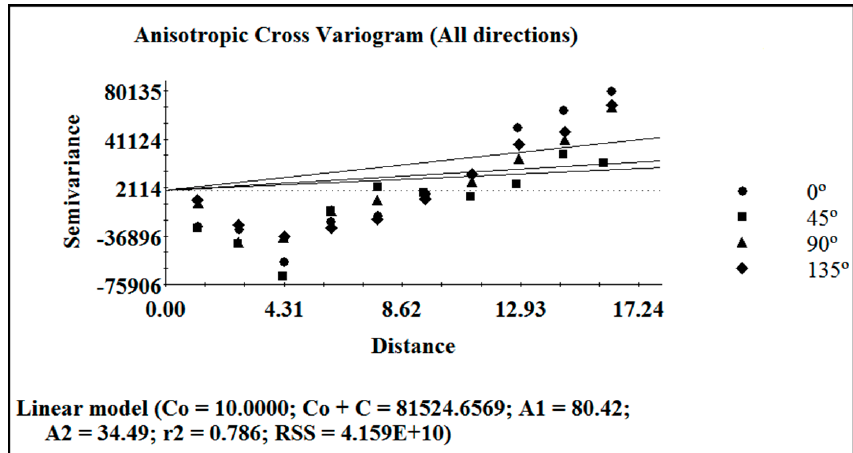
Figure 11. Spatial correlation between the DEM and Rainfall.